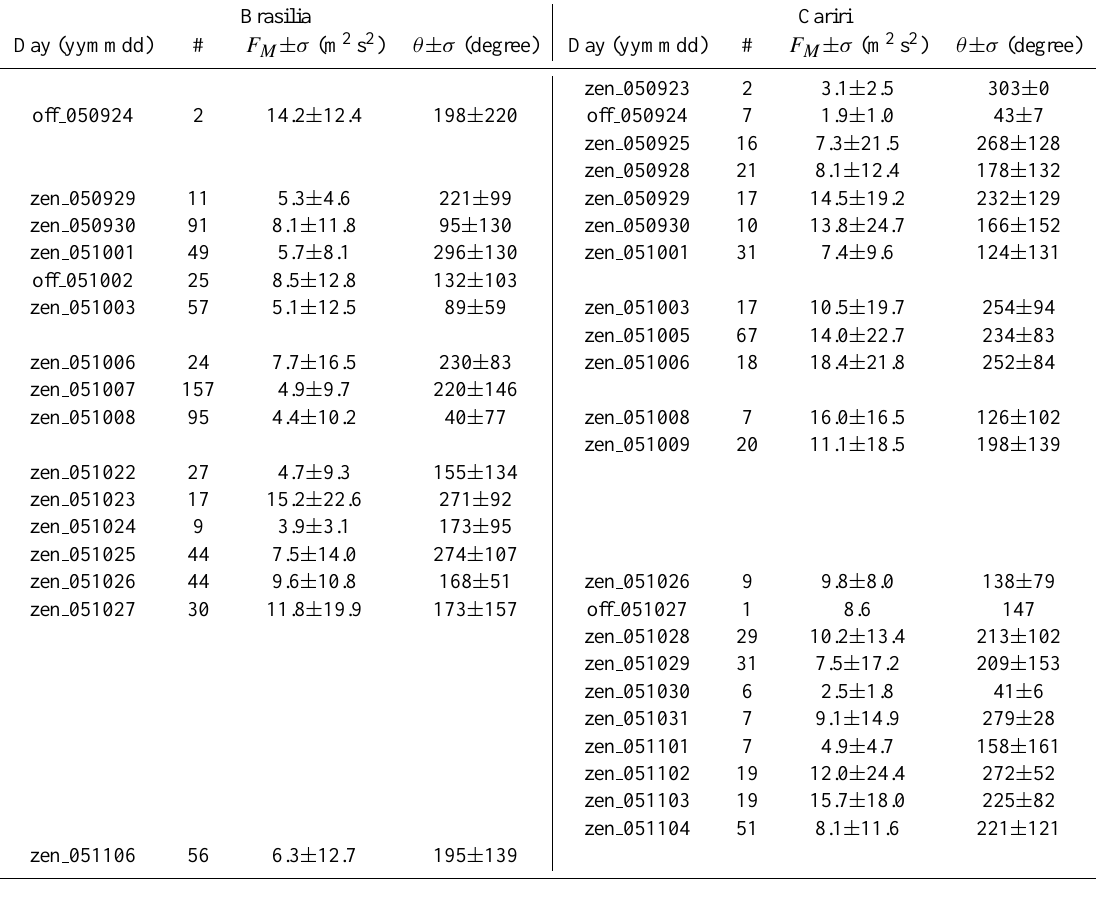
Table 1. Momentum flux ( F M ) and propagation direction ( θ ) of gravity waves observed in Cariri and Brasilia. The standard deviation of each parameter is also showed in the table. The label “#” refers to the number of GW events detected by the analysis method. Prefixes “zen” and “off” refer to the analysis performed at zenith and off-zenith of the image,